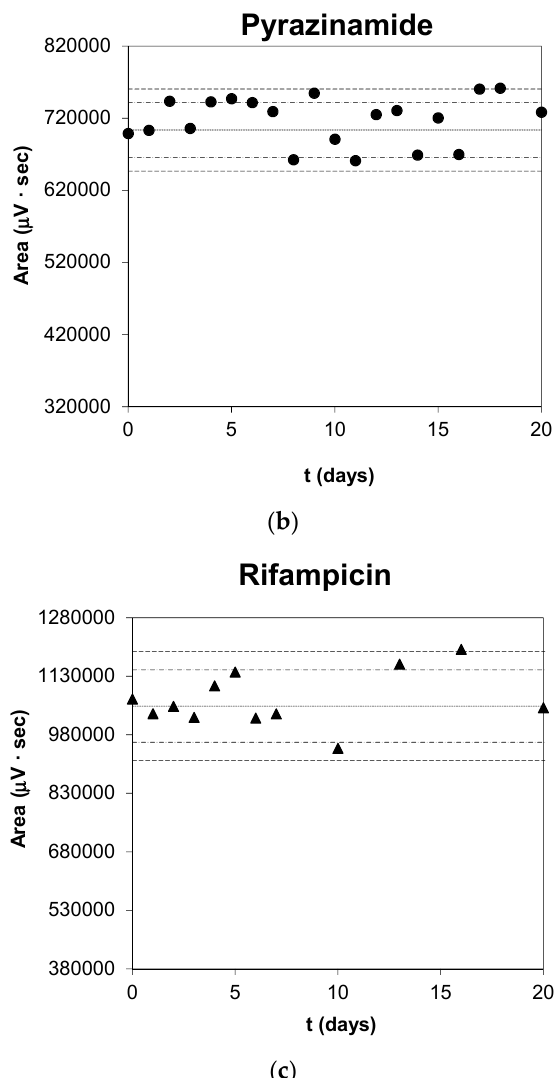
Figure 1. Control chart of the UPLC method for each antiTB. The estimated areas, warning (±2SD), and action limit (±3SD) are marked with a dashed, dashed, and dotted, and more dashed line respectively.